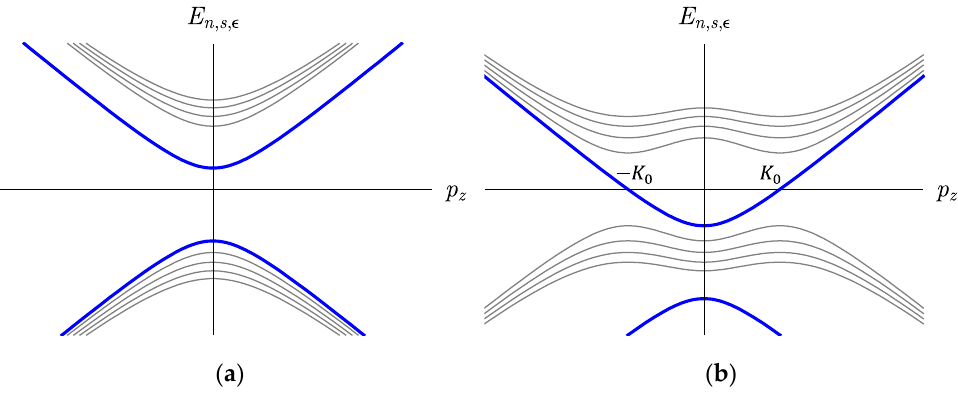
Figure 4. Energy spectra in the presence of magnetic field. Left panel ( a ) is for the case of M > q , while right panel ( b ) is for the case of M < q . Lowest Landau level (LLL) for each case is denoted by the bold lines.